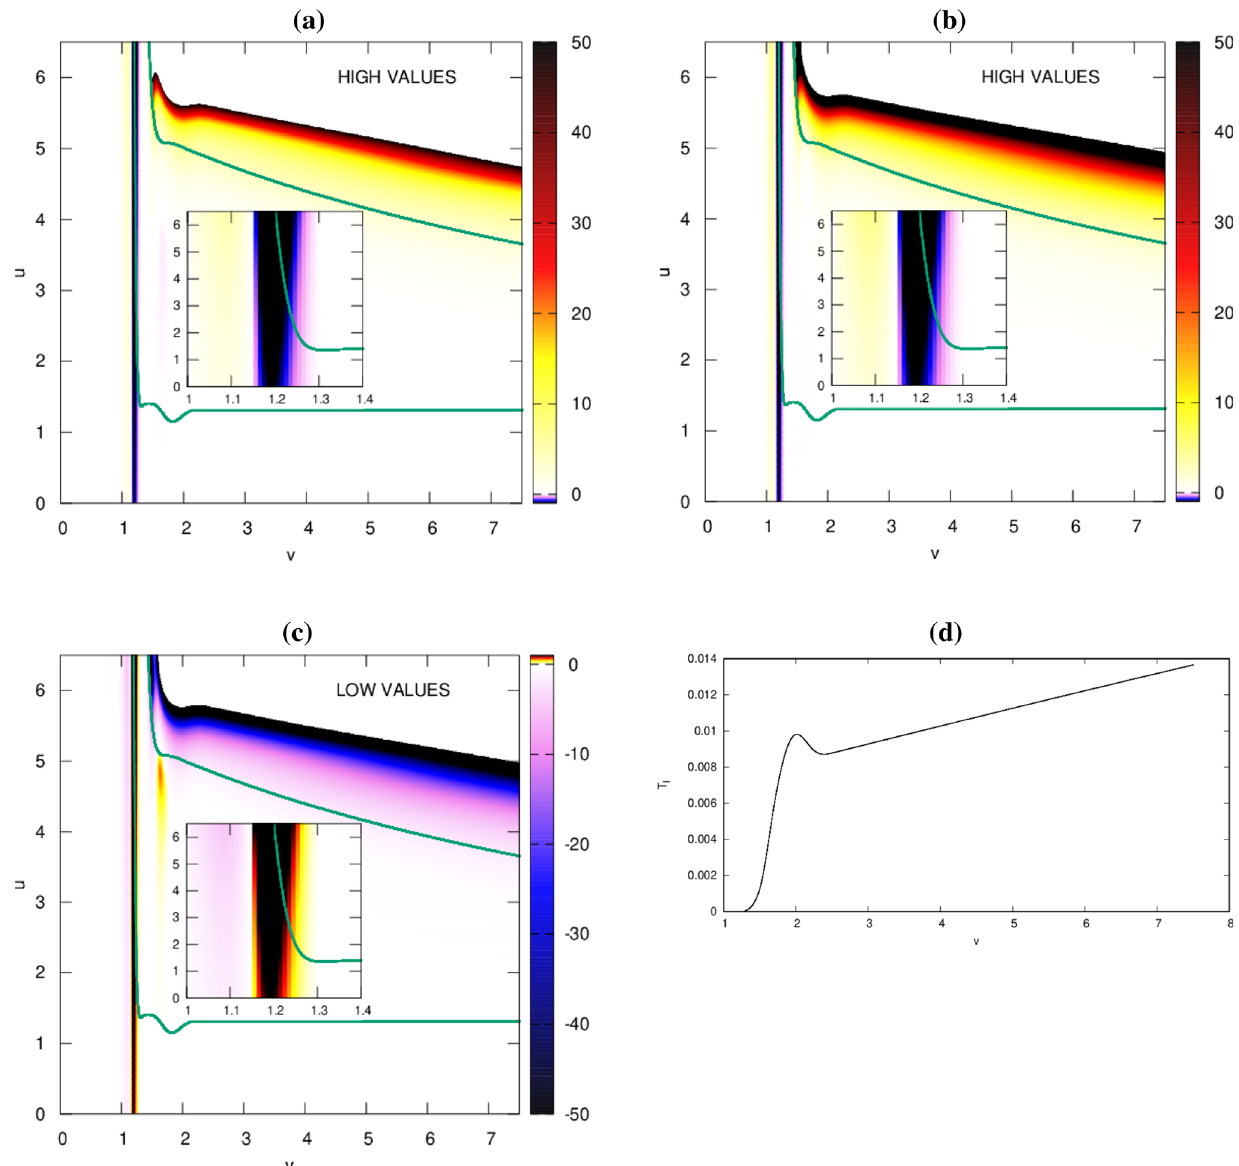
Fig. 17 The (v u ) -distribution of a energy density, ˆ ρ , b radial pressure, ˆ p ˆ p r , and c pressure anisotropy, a , and d local temperature along the black hole outer apparent horizon, T l , as a function of advanced time for